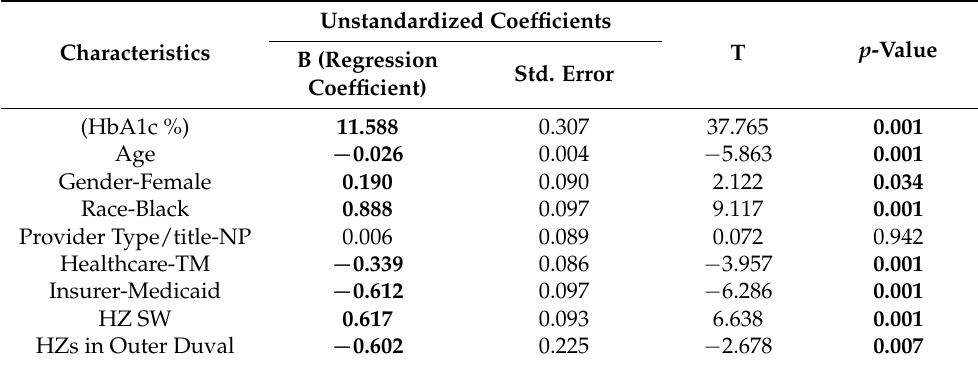
Table 2. Multiple Linear Regression Model Analyzing HbA1c % Levels and